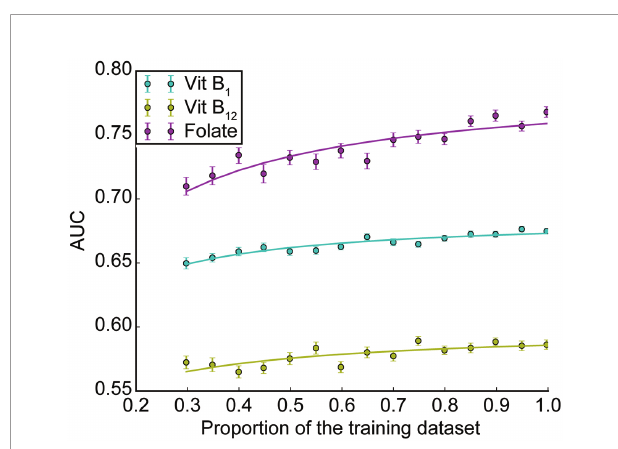
FIGURE 4 | Subsampling analysis. The AUC performances as a function of the dataset size is shown for each vitamin (mean ± SEM across 100 repetitions; see Methods for